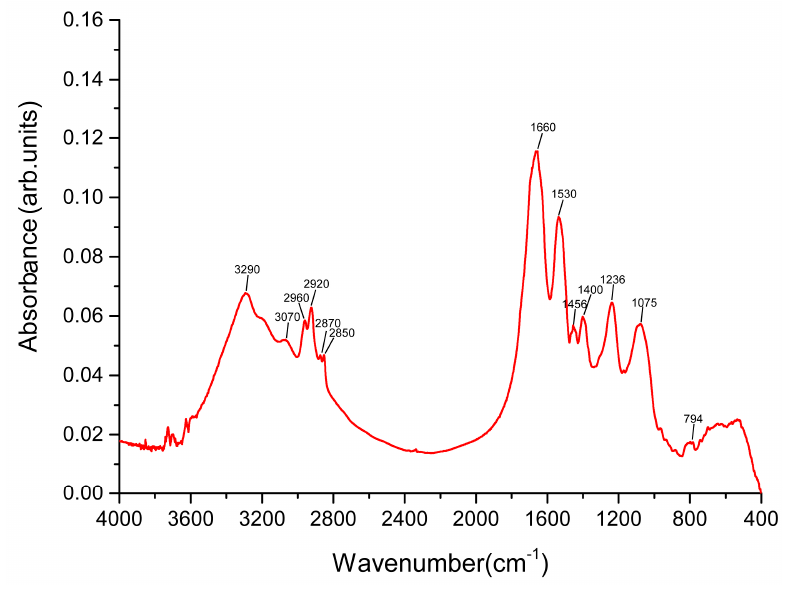
Figure 1. The FTIR spectrum of SeNPs synthesized by isolate YC801.